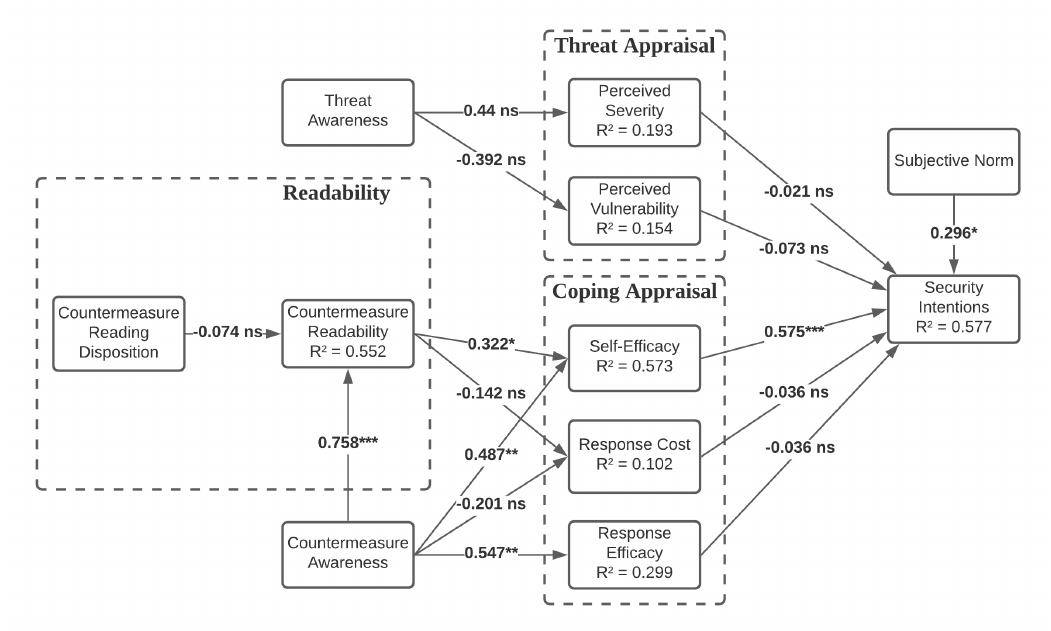
Figure 3. The research model results. Note: ∗ p < 0.05; ∗∗ p < 0.01; ∗∗∗ p < 0.001; ns —not significant. Figure 3 corresponds with the structural, or inner, model of the PLS-SEM model. After having analyzed the outer model in Section 4.3, the structural model was analyzed. The path coefficients the PLS algorithms produced can be interpreted as regular beta